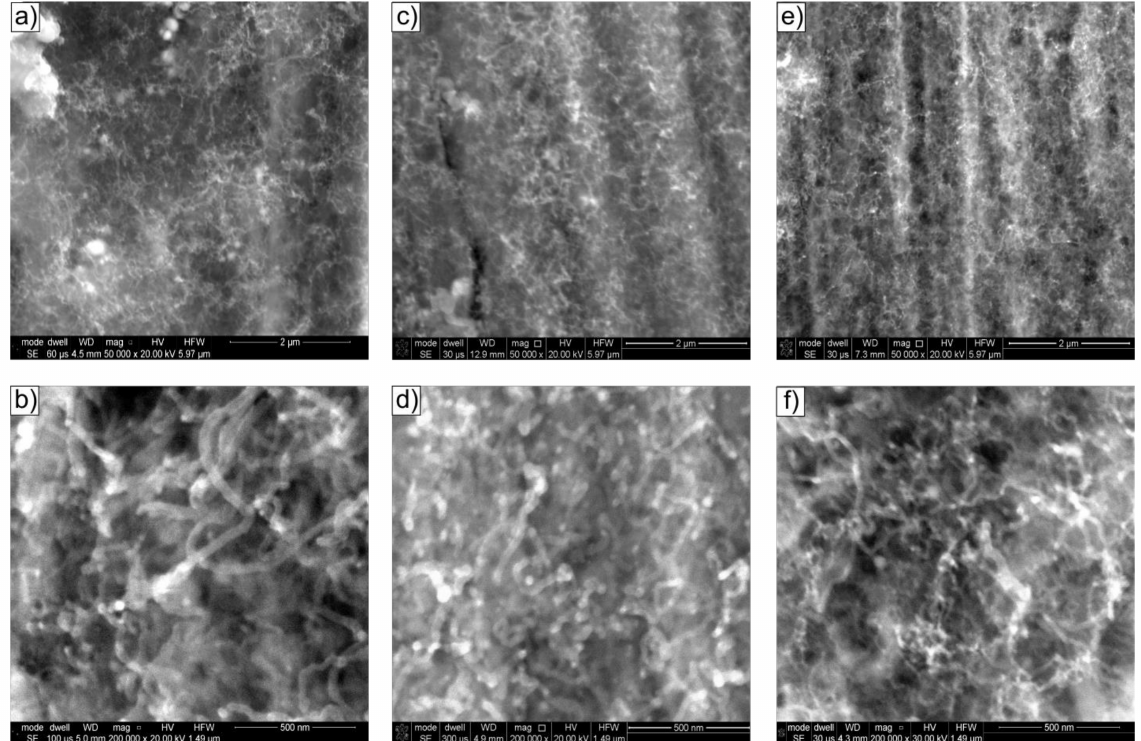
Figure 4. SEM morphology of Ni 3 Al foils surface after decomposition of ethanol with addition of 0.5 wt.% water steam (mixture #3) at: ( a , b ) 500 ◦ C, ( c , d ) 600 ◦ C, and ( e , f ) 700 ◦